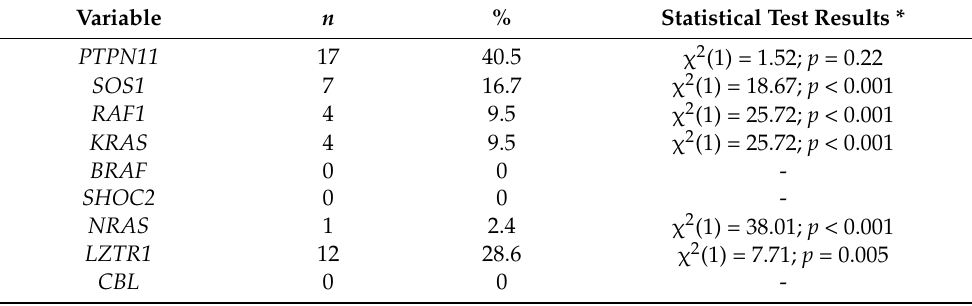
Table 3. Subject groups distinguished by genetic mutations.